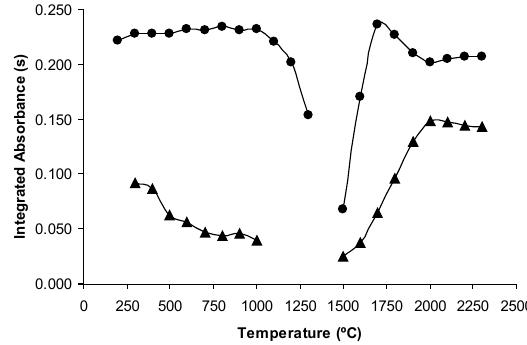
Figure 1. Pyrolysis and atomization curves of a 37.0 µg L -1 antimony standard solution with ( ● ) and without ( ▲ ) Pd-Mg(NO mixed chemical modifier.